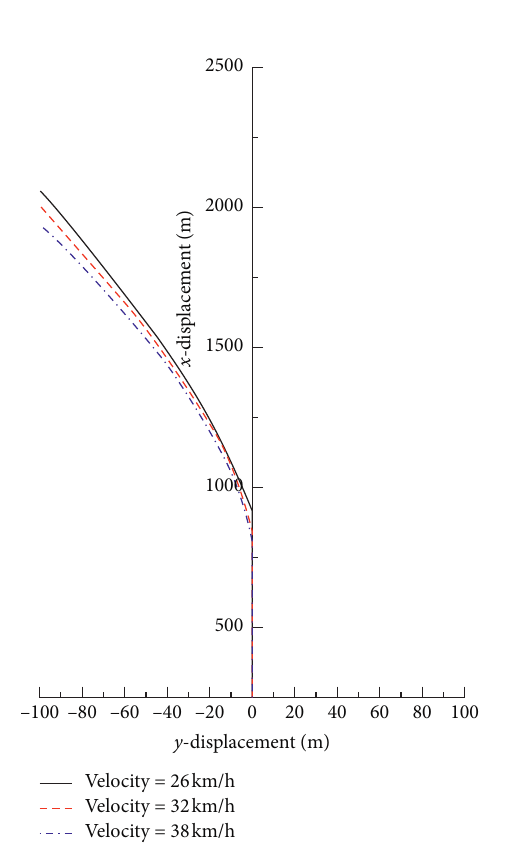
Figure 17: Ship’s trajectory without steering at 400m. Figure 18: Ship’s trajectory without steering at 500m.